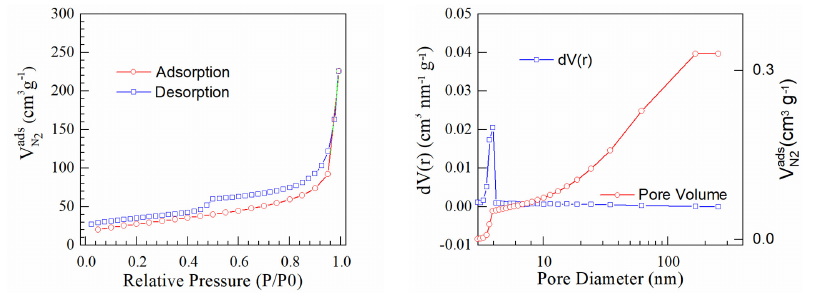
Figure 7. Sample PtrGO3. Table 3. BJH desorption summary [34].